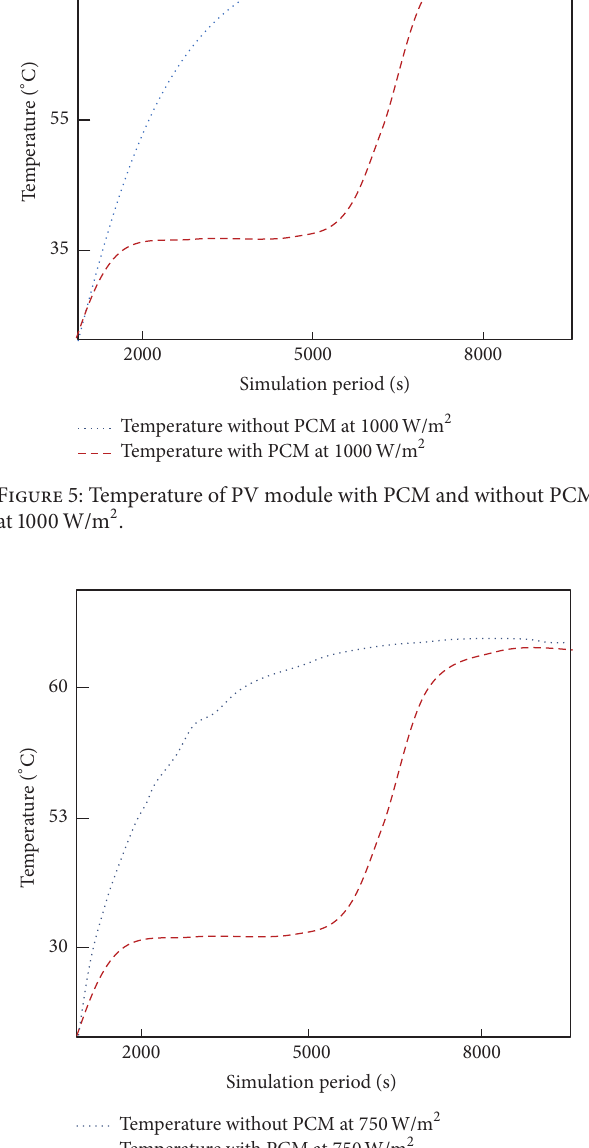
Figure 6: Temperature of PV module with PCM and without PCM at 750 W/m 2 .